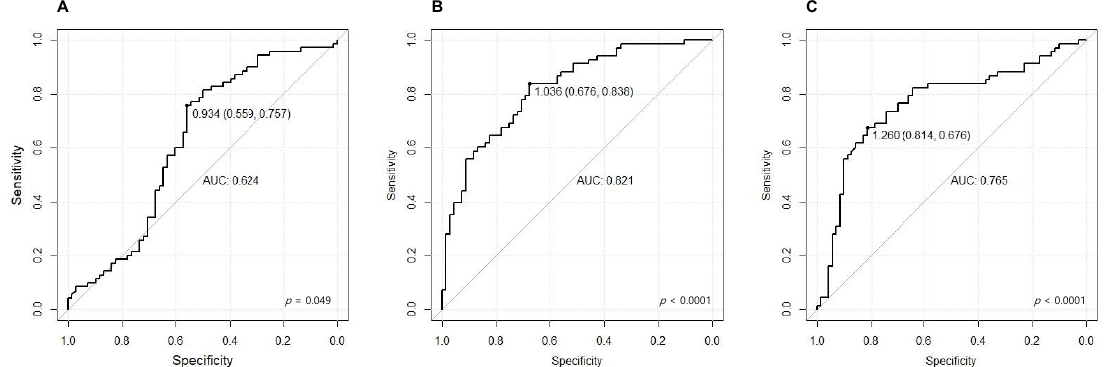
Figure 4. The AUROC of serum AsAGP levels for differentiating liver fibrosis and cirrhosis in CHB patients compared to that in healthy controls. ( A ) CHB patients versus healthy controls, ( B ) CHB patients with LC versus healthy controls, ( C ) CHB patients versus CHB patients with LC.